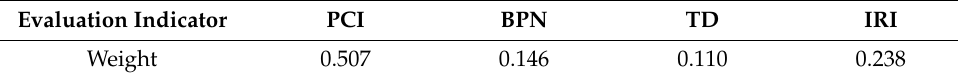
Table 9. Weights of the evaluation